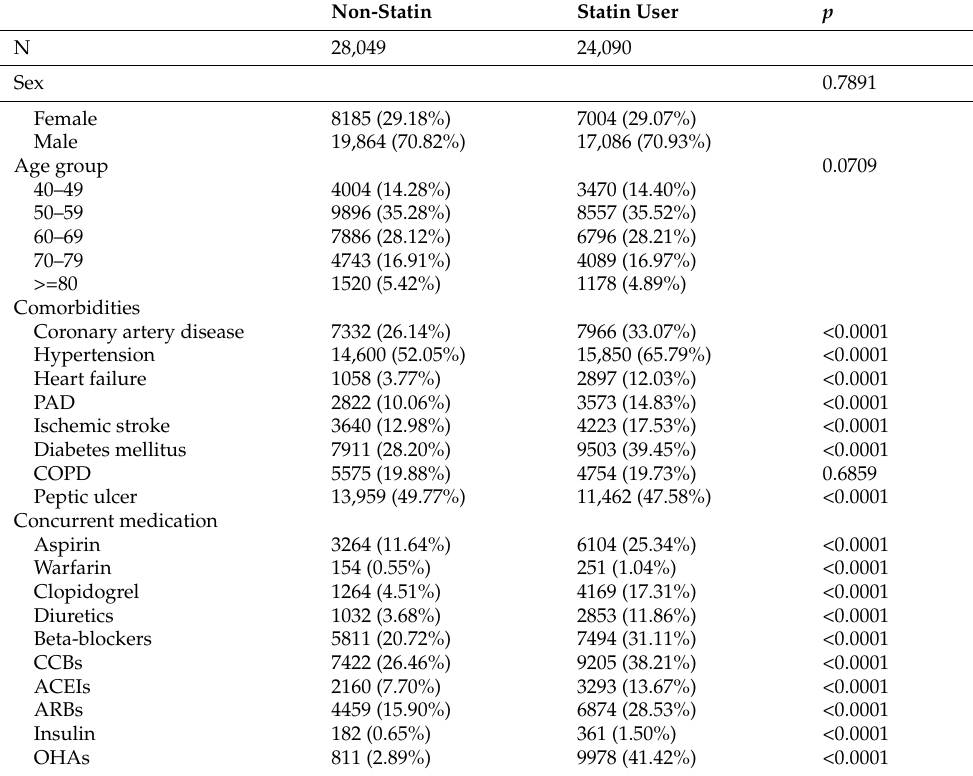
Table 1. Baseline characteristics in patients with chronic kidney disease.